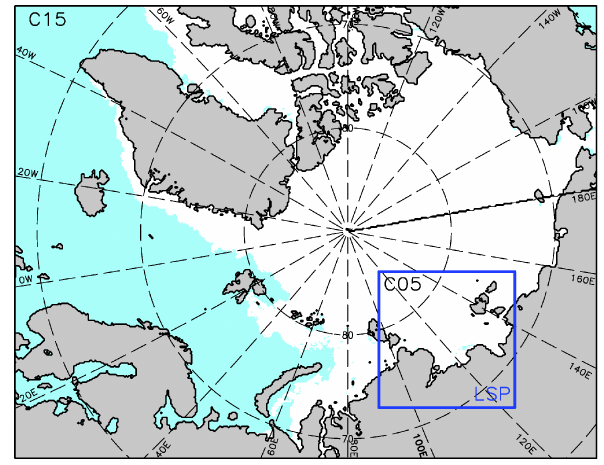
Figure 1. Model domains of COSMO-CLM at a horizontal resolu- tion of 15km (C15, whole Arctic). The study domain of the Laptev Sea polynyas (LSP) with a resolution of 5km (C05, blue box) is shown in detail in Fig. 2. The sea-ice extent (white shaded) is from 4 January 2008.